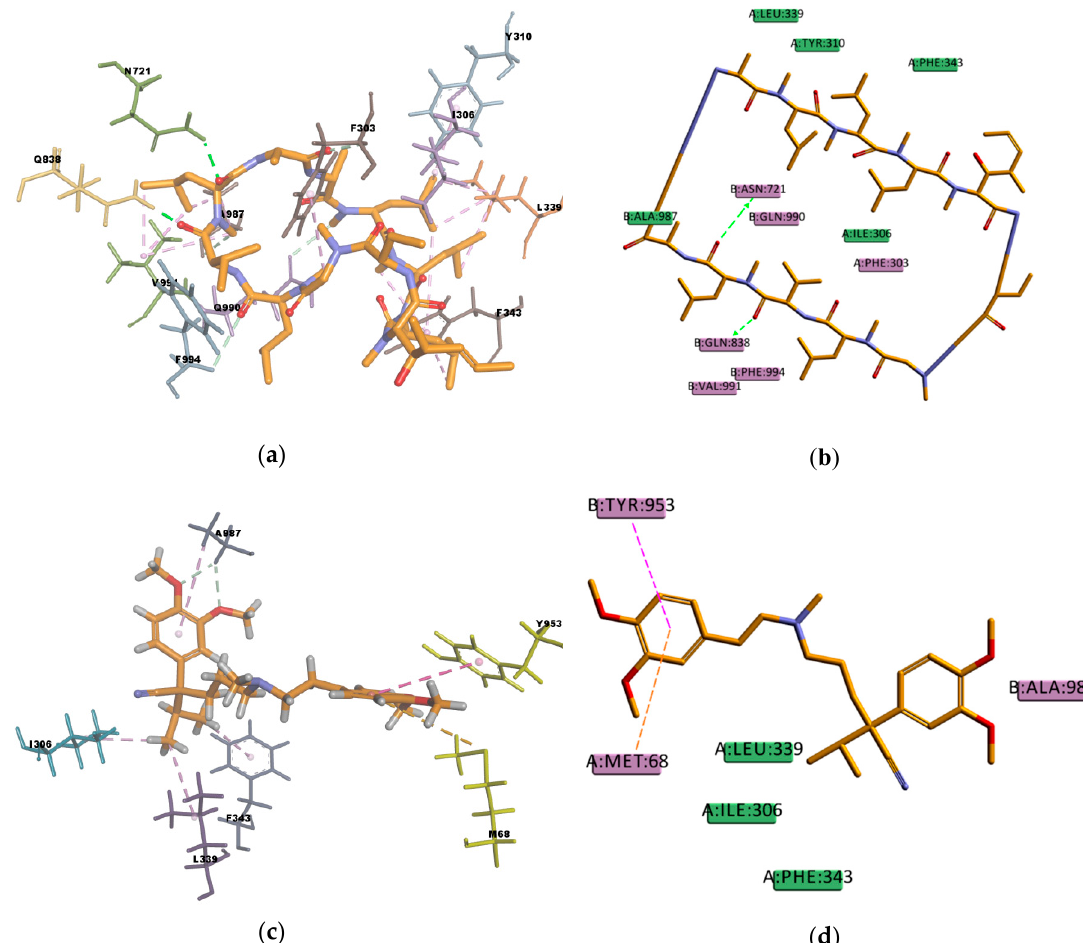
Figure 8. ( a ) Distribution of the selected ligand poses (yellow) in the homology model of h P-gp; ( b ) View from the extracellular side of the protein looking into the internal chamber. The colors representation is according to the secondary structure: helices are red, beta sheets are cyan, turns are green, and coils are white.